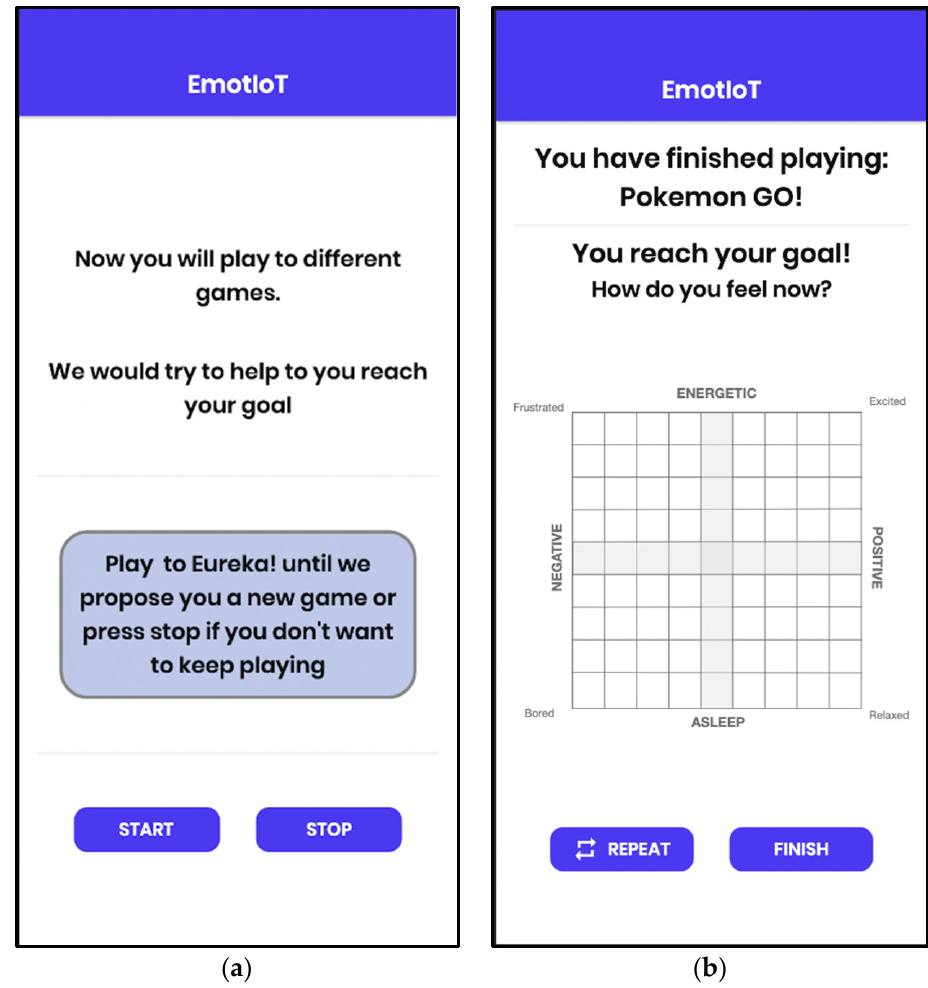
Figure 5. Screens to ( a ) tell the player what to play the first time, and ( b ) target range check screen.